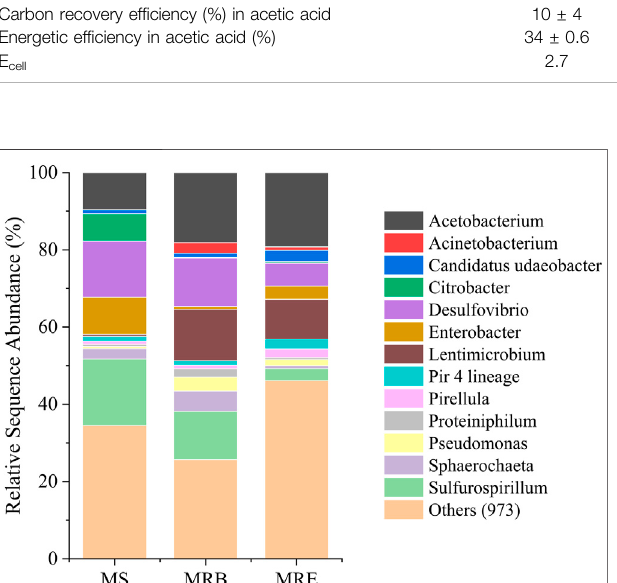
FIGURE 5 | 16S rRNA sequencing-based microbial community composition at the genus level in the CO 2 fi xing microbial inoculum source (MS) used in microbial electrosynthesis (MES) experiments, along with the MES biocathode (MRE) and MES bulk phase (MRB) samples. For MRE and MRB, the average data of duplicates are